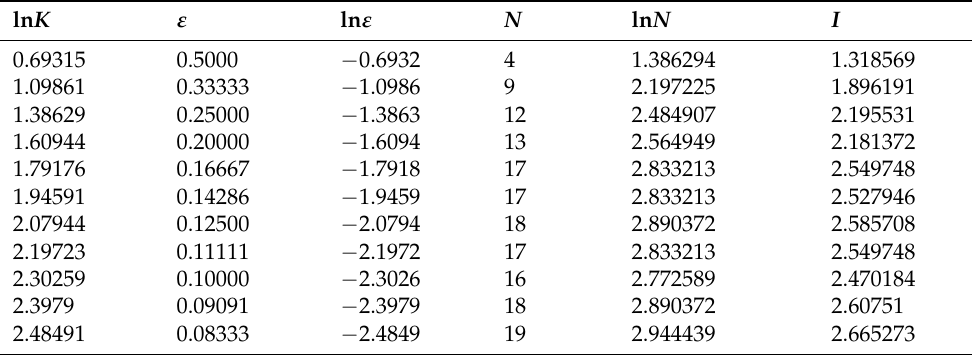
Table A6. Measurements for park system grid capacity dimension.